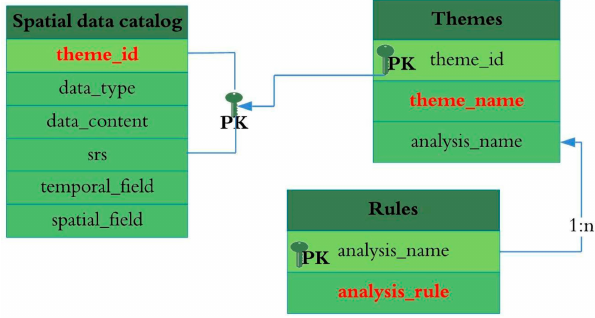
Figure 9. ER (Entity-Relation) model of the ontology